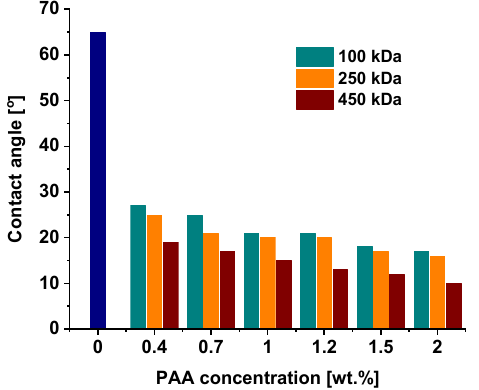
Figure 6. Dependence of the water contact angle of the membrane skin layer on the concentration of PAA of different molecular weights in the coagulation bath. 3.5. Effect of the PAA Molecular Weight on ξ‐ Potential of the Membrane Skin Layer